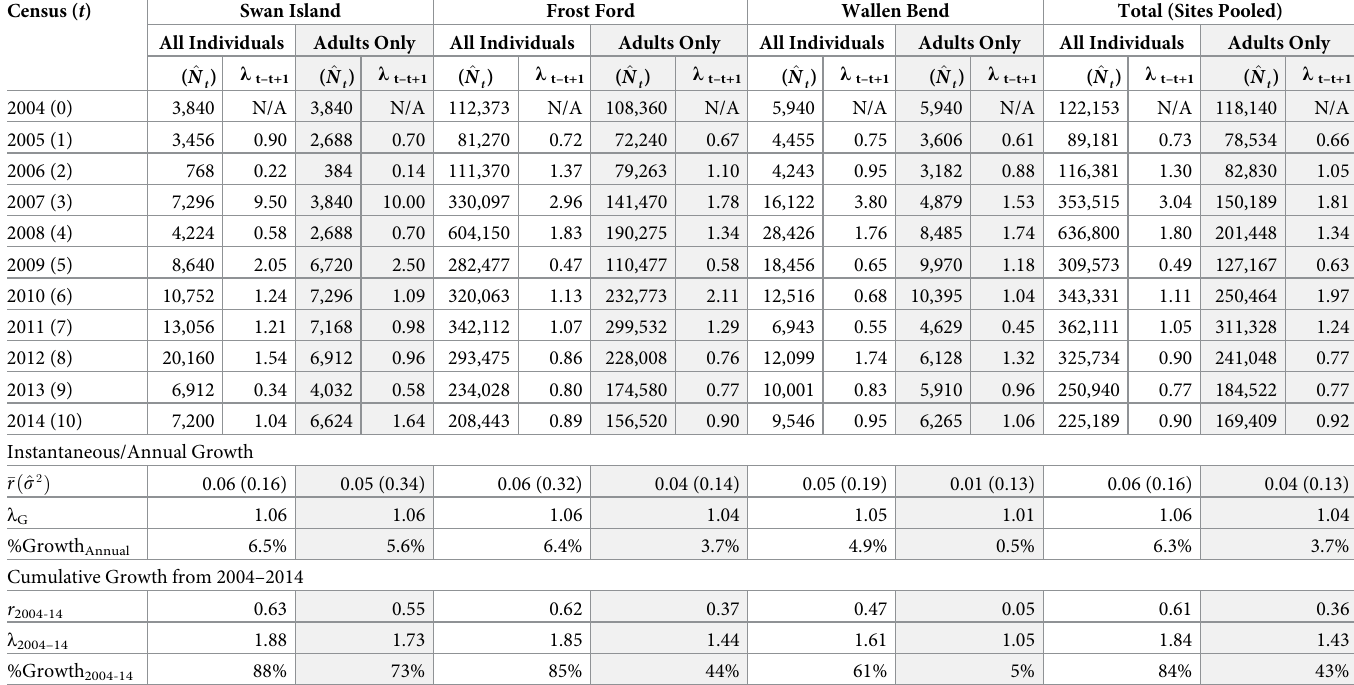
Table 4. Estimated population size per census ( ^ N ), finite rate of population increase [ λ t − t +1 ] per time step, per capita or instantaneous rate of increase [ � r ], and t cumulative population growth observed in populations of Epioblasma capsaeformis in the Clinch River, TN at Swan Island, Frost Ford, Wallen Bend, and Total (Sites Pooled) from 2004–2014.